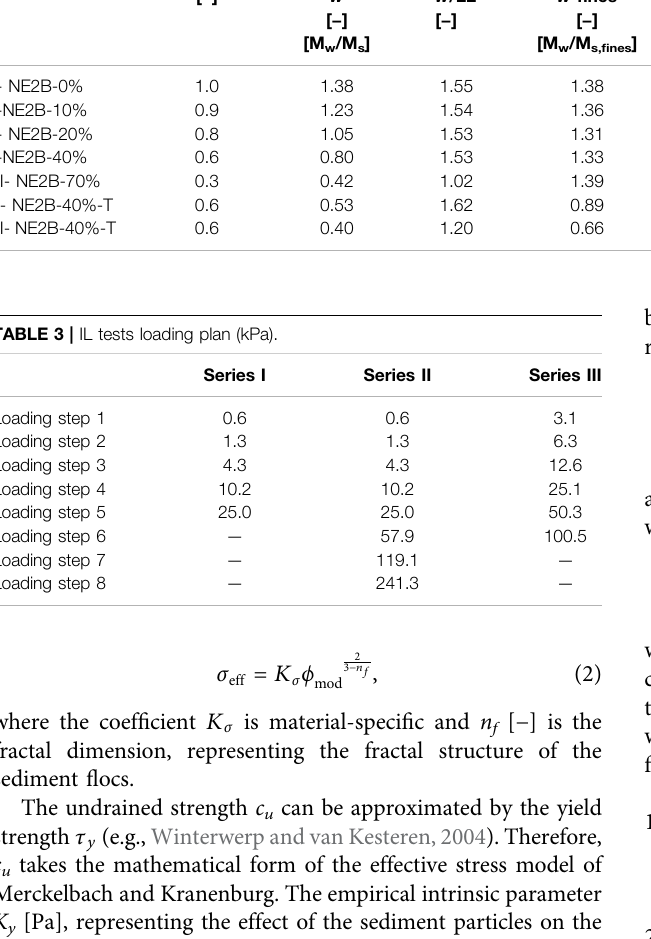
TABLE 2 | Initial and fi nal water contents of the IL tests, including water content of the fi ne fraction and ratios between initial and fi nal water contents and the liquid limit. Sample ID Fines Initial Final content